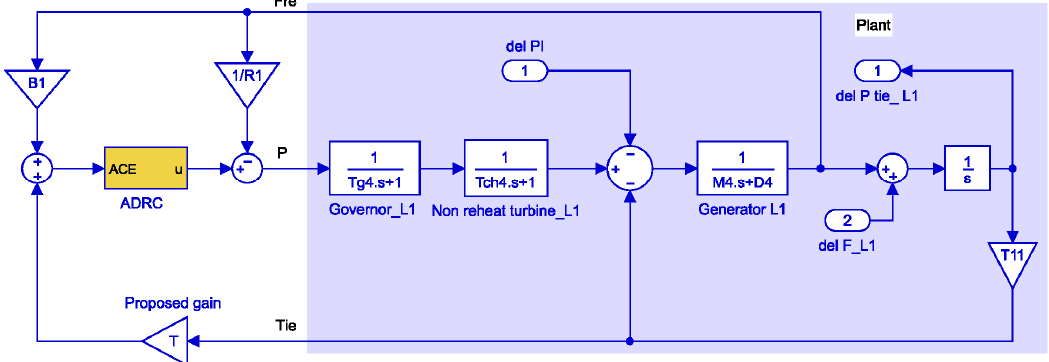
Figure 9. Proposed dynamic model for load change from L 1 to G 1.